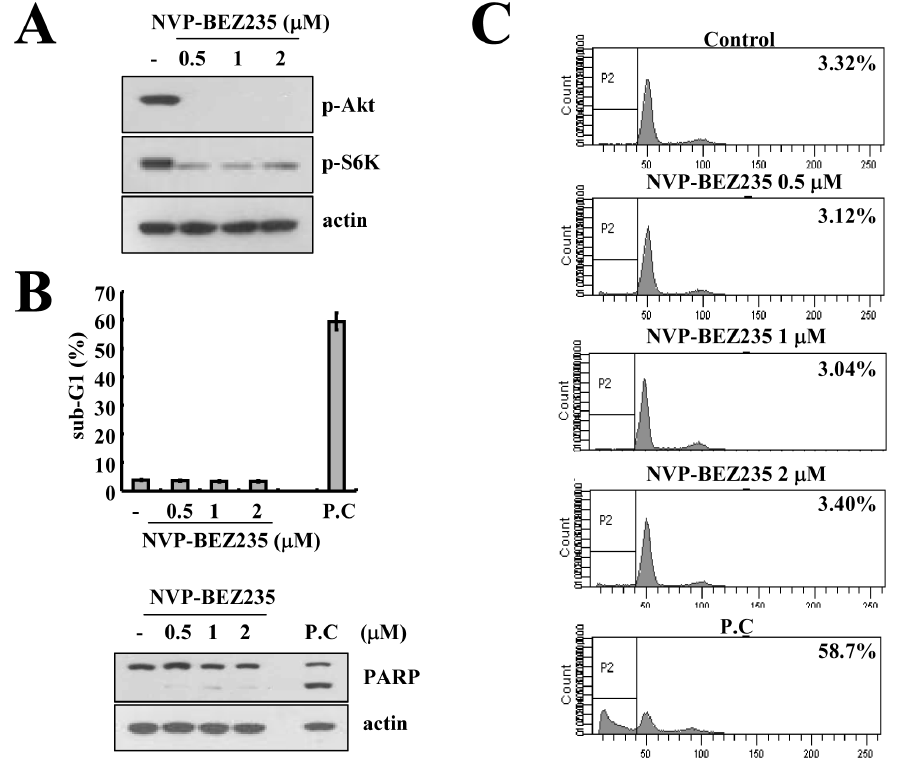
Figure 1. Effect of NVP-BEZ235 on apoptosis in human renal carcinoma Caki cells. Caki cells were treated with the indicated concentrations of NVP-BEZ235 for 48 h. (A) Equal amounts of cell lysate (40 m g) were subjected to electrophoresis and analyzed by western blotting for phospho (p)-Akt and p-S6K as well as actin as a control for protein loading. (B and C) Caki cells were treated with 100 nM TNF- a and 20 m g/ml cycloheximide for 48 h and used as a positive control (p.c.). The sub-G1 fraction was measured by flow cytometry (upper panel) as an indicator of the level of apoptosis. Equal amounts of cell lysate (40 m g) were subjected to electrophoresis and analyzed by western blotting for PARP and actin as a control for protein loading (lower panel). The values in (B) represent the mean 6 SD from three independent samples. The data represent three independent experiments.